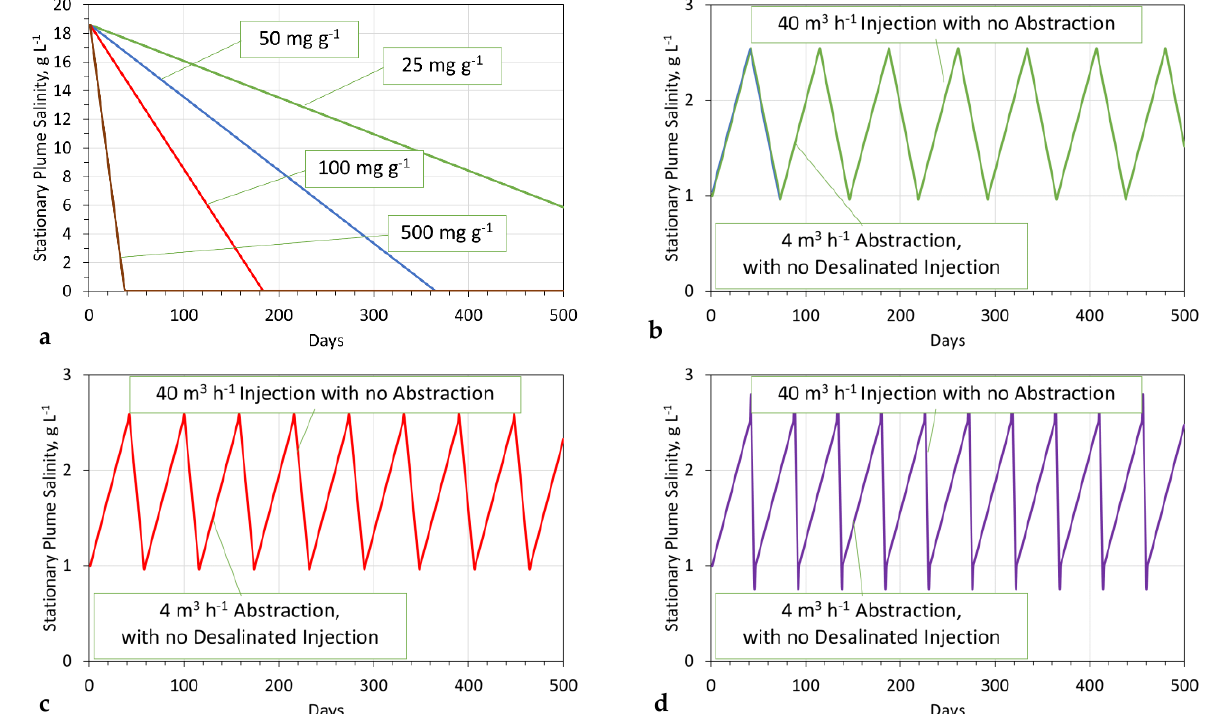
Figure A9. Modeled stationary plume. ( a ) Time required to reduce the plume salinity as a function of adsorbent quality; ( b ) relationship between periods of irrigation abstraction and periods of additional plume desalination and adsorbent quality = 50 mg g − 1 ; ( c ) relationship between periods of irrigation abstraction and periods of additional plume desalination and adsorbent quality = 100 mg g − 1 ; ( d ) relationship between periods of irrigation abstraction and periods of additional plume desalination and adsorbent quality = 500 mg g −1 .